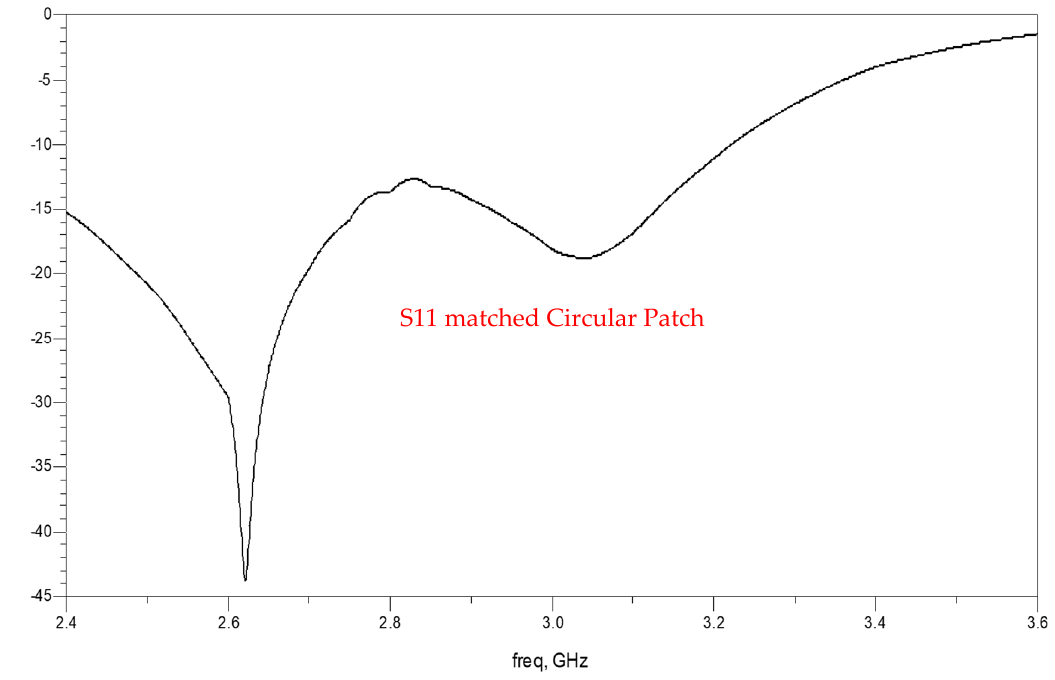
Figure 7. S11 of the Circular patch receiving antenna.